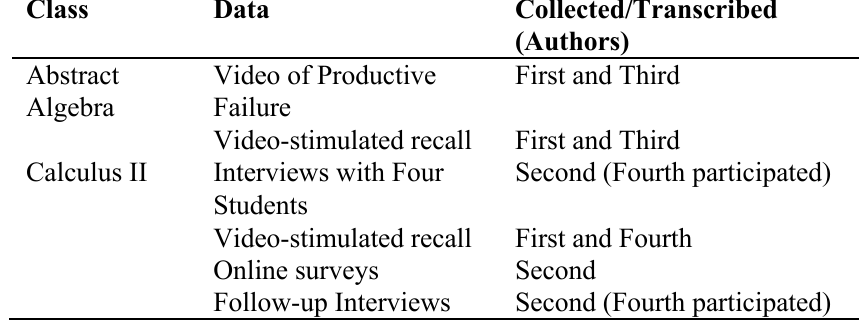
Data Collection by